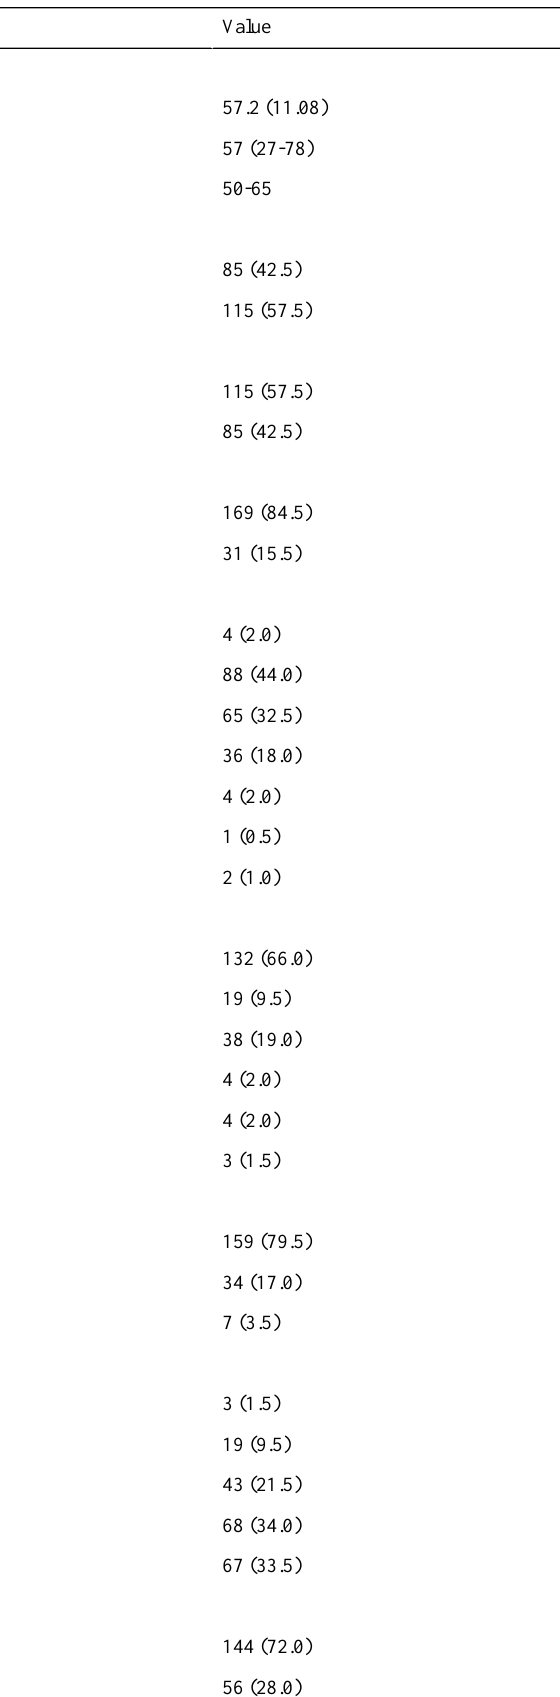
Table 1. Patient characteristics before radiotherapy